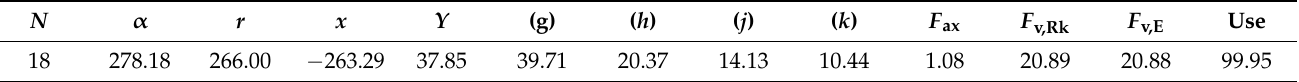
Table 6. Results of calculation of the characteristic capacity of the connection according to [40,41] for test sample no. 2 and sample no. 4, bolts and